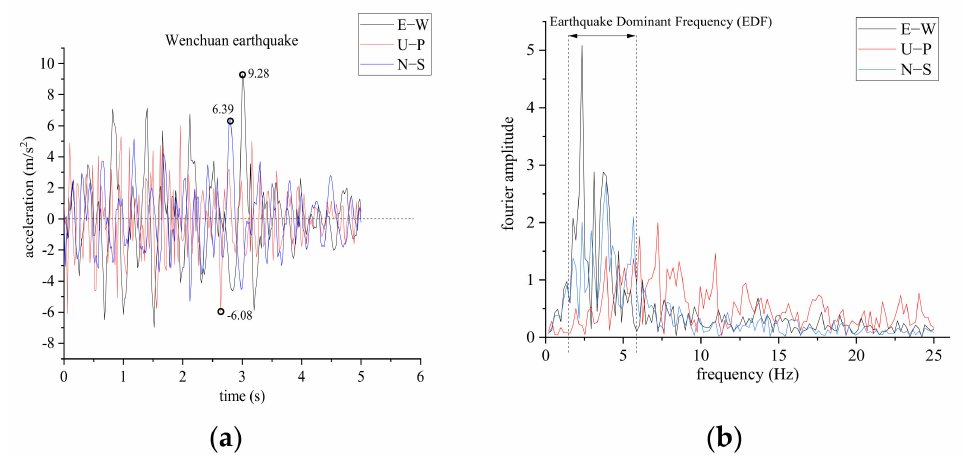
Figure 5. The nature of the input acceleration used in this work (Wolong waves of the Wenchuan earthquake), showing: ( a ) the acceleration history with a holding time of 5 s and E–W, U–P, and N–S PGA values of 9.28, 6.39, and − 6.08 m/s 2 , respectively, and ( b ) the corresponding Fourier spectra and earthquake dominant frequency range (1.5–6 Hz).